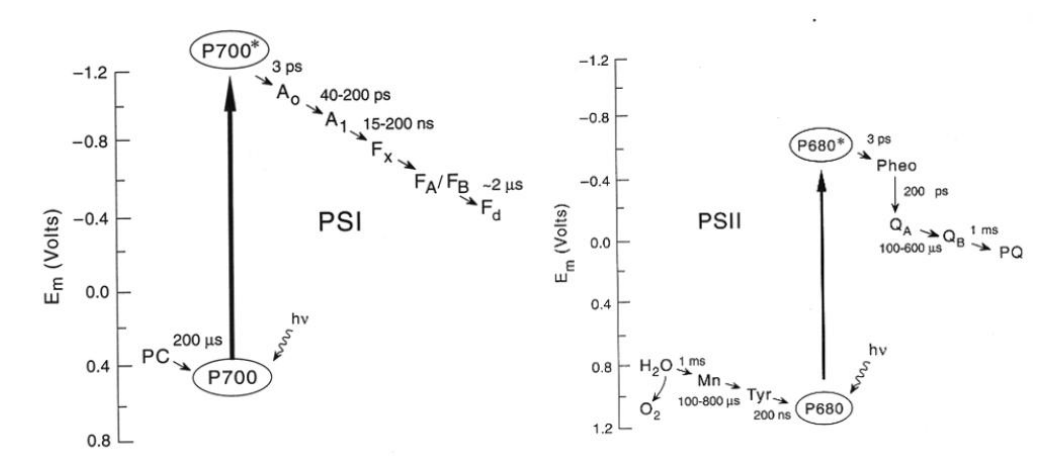
Figure 4. Pathways and rates of electron transfer reactions in PS I (left panel) and PS II (right